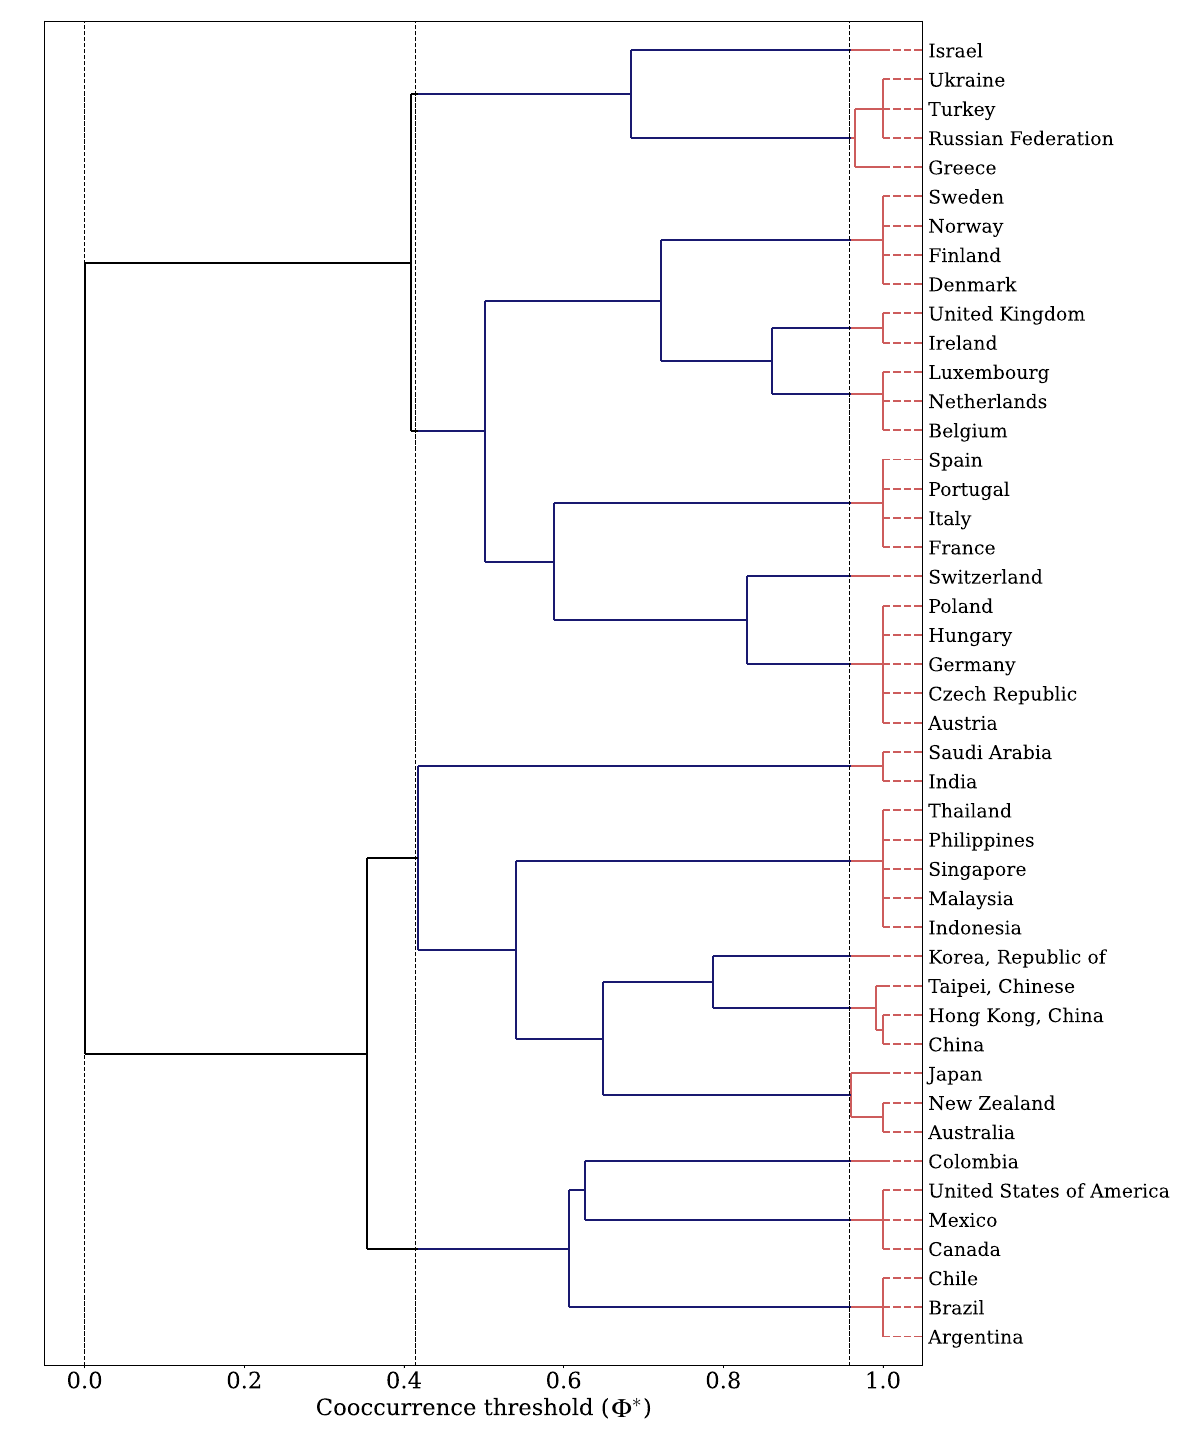
Figure 3. The dendrogram of the international trade network in 2018 constructed by the hierarchical decomposition analysis. The horizontal axis refers to the cooccurrence threshold (cid:31) ∗ . The vertical dashed lines are drawn for (cid:31) ∗ = 0 , 0.41 and 0.96, which correspond to Fig. 4a–c